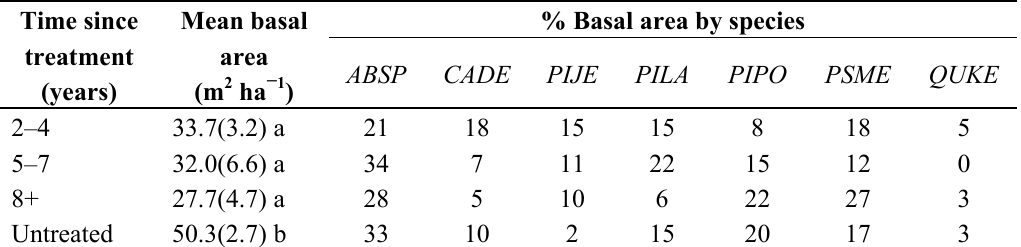
Table 2. Mixed conifer mean basal area (standard error) and mean contribution of each tree species to total basal area for each time-since-treatment category. Different letters indicate significant difference in means between groups (Tukey’s HSD multiple comparison test, p < 0.05). Calculations include all trees with diameter at breast height ≥ 2.5 cm. Species composing less than 1% of basal area are not included in % basal area calculations. See Table 1 for explanation of species